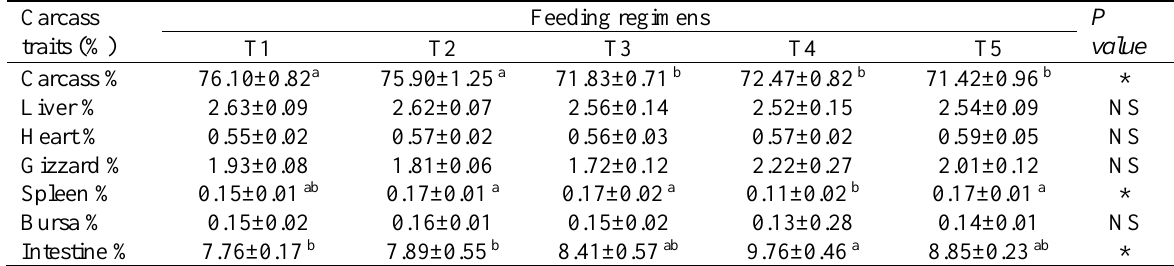
Table 6: Effect of feeding frequency and amount on carcass traits (%) of broiler (Means±SE).